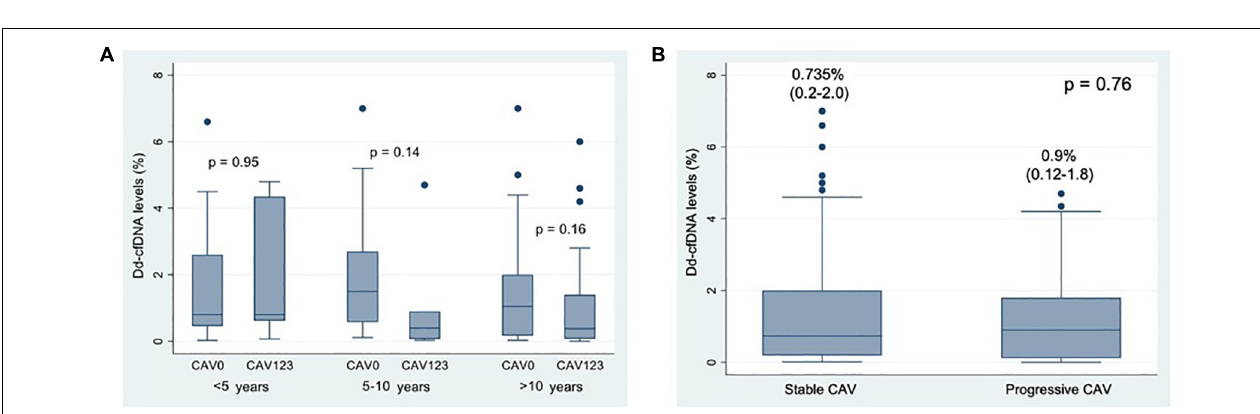
FIGURE 4 | (A) Box-plot of Donor-derived Cell Free DNA levels according to time after heart transplant. (B) Box-plot of Donor-derived Cell-Free DNA according to CAV progression. Numerical data represent median dd-cfDNA values and their interquartile range.